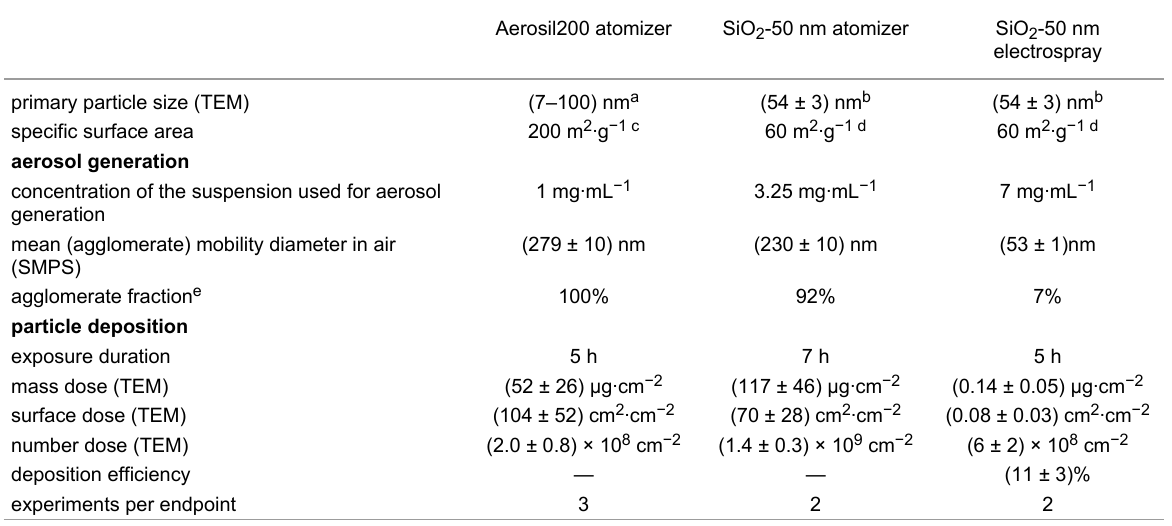
Table 1: Characteristics of the particles, the aerosol generation and deposition with electrostatic field.